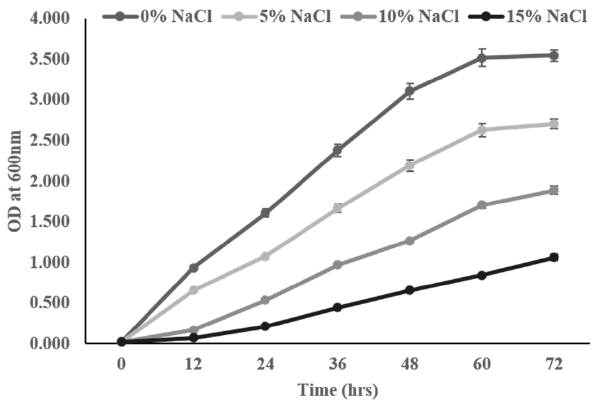
Figure 2. Growth kinetics of the salt-tolerant bacterial strain ASN-1 at different NaCl concentrations.